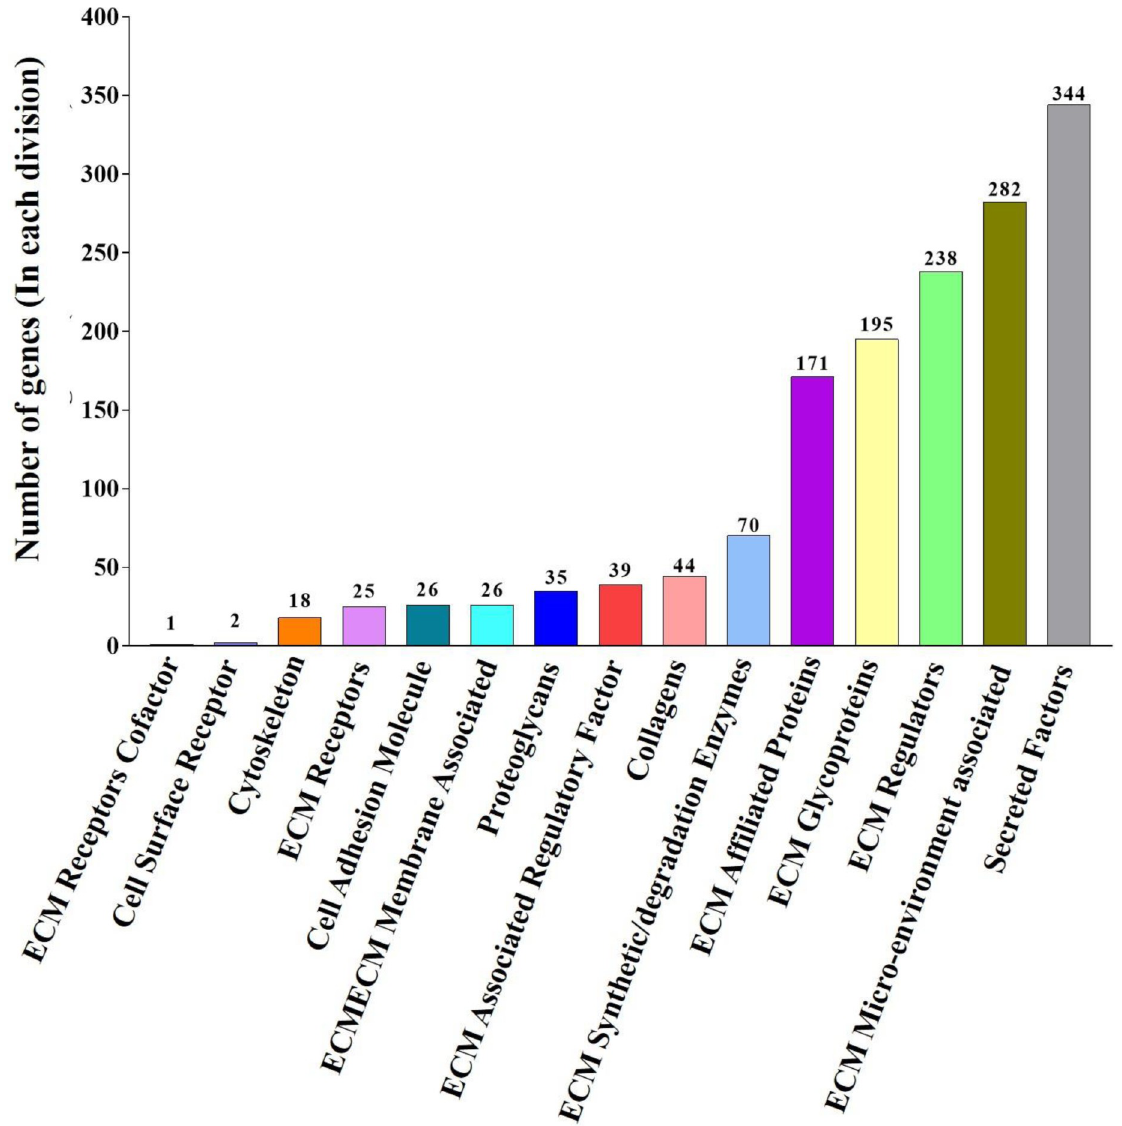
Fig 3. PAN-ECM Data List description generated by a literature search. Bar chart indicated the distribution of total 1516 PAN-ECM genes in the 15 classified categories. Numbers of the PAN-ECM genes in each category are shown at the top of each bar.